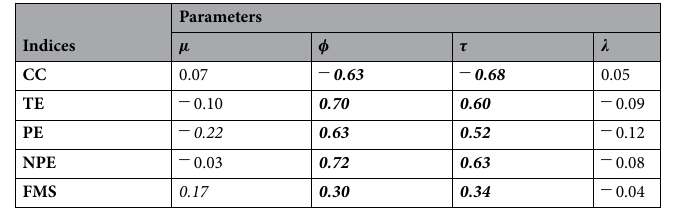
Table 3. Pearson’s correlations between key parameters ( µ , φ , τ , (cid:31) ) and WCST indices in the case of a low language contribution ( (cid:31) < 0.05 ). Bold indicates correlations above |0.3| and Italics the statistically significant ones ( p < 0.05